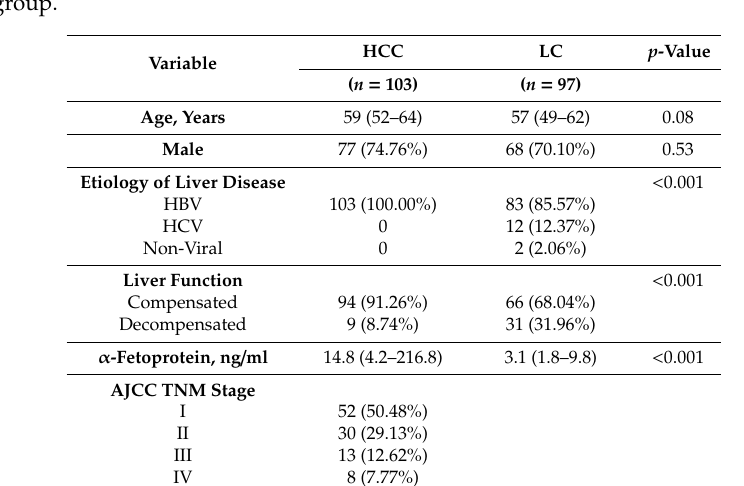
Table 1. Basic characteristics of the subjects in each HCC (hepatocellular carcinoma) and LC (liver cirrhosis) group.